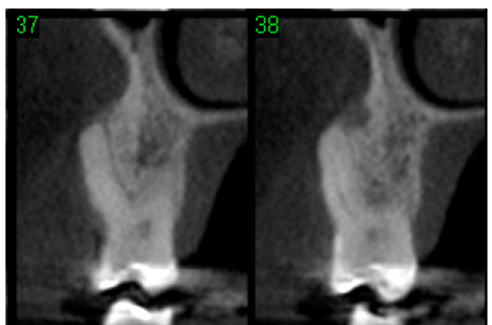
Figure 12. Computerized tomographic view of 2 slices (37 and 38) of #16 evidencing lack of buccal plate.